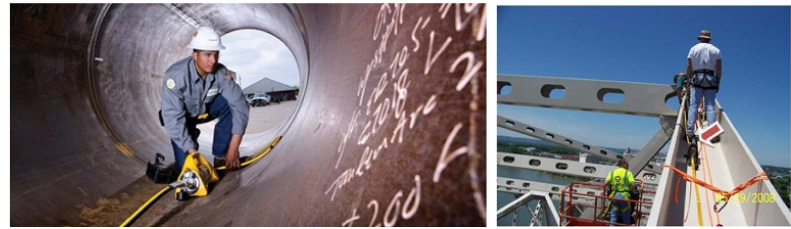
Figure 20. Inspection of a steel pipe using RT Method